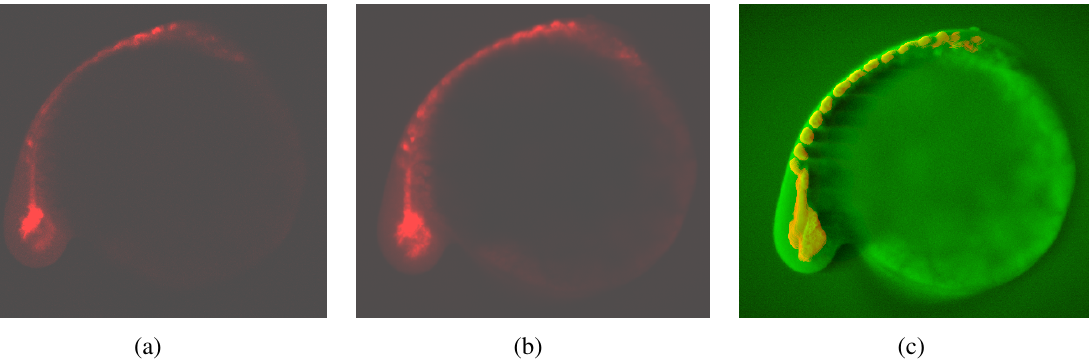
Figure 1: The zebrafish gene expression pattern of the MyoD gene at 24 hours post fertilization (hfp). (a) shows one slice of a 3D image, (b) shows a projection of the 3D image onto one 2D image and (c) a 3D visualization of both channels of the 3D image, i.e. the pattern in the context of the whole zebrafish embryo. The expression gene, i.e. MyoD is involved in development of vertebra and